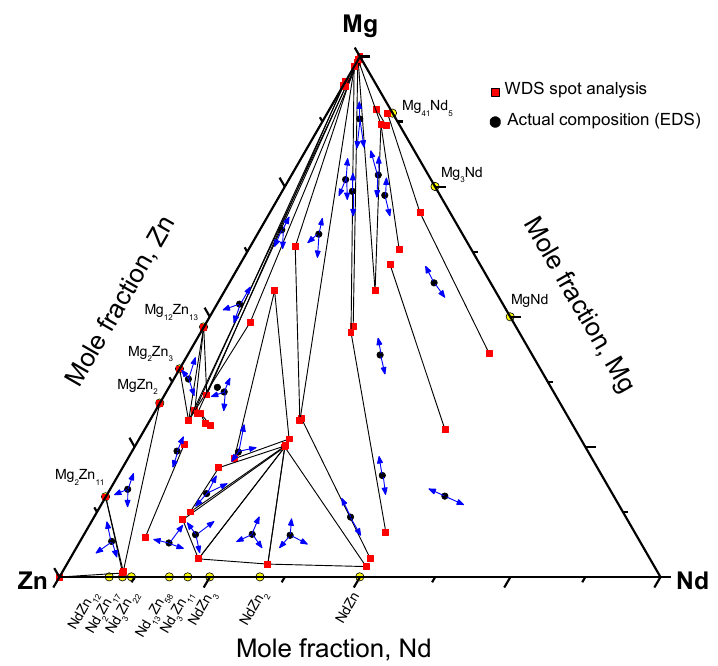
Figure 10. Phase equilibrium results obtained from WDS spot analysis of equilibrated key alloys, where the arrows point to the detected